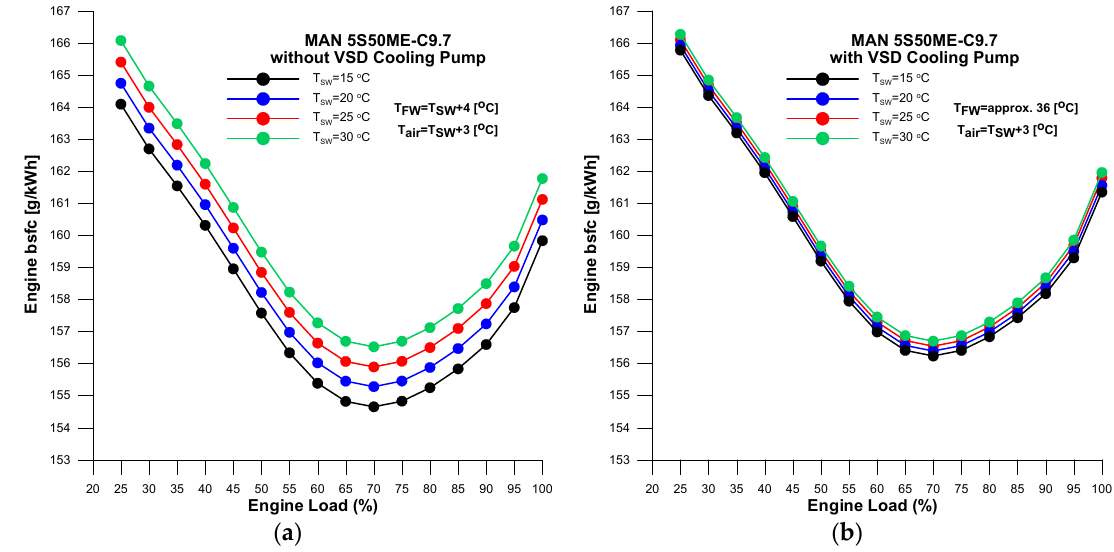
Figure 12. Comparison of the effect of seawater temperature on engine bsfc [g/kWh] at various engine loads with and without the use of VSD SW cooling pump